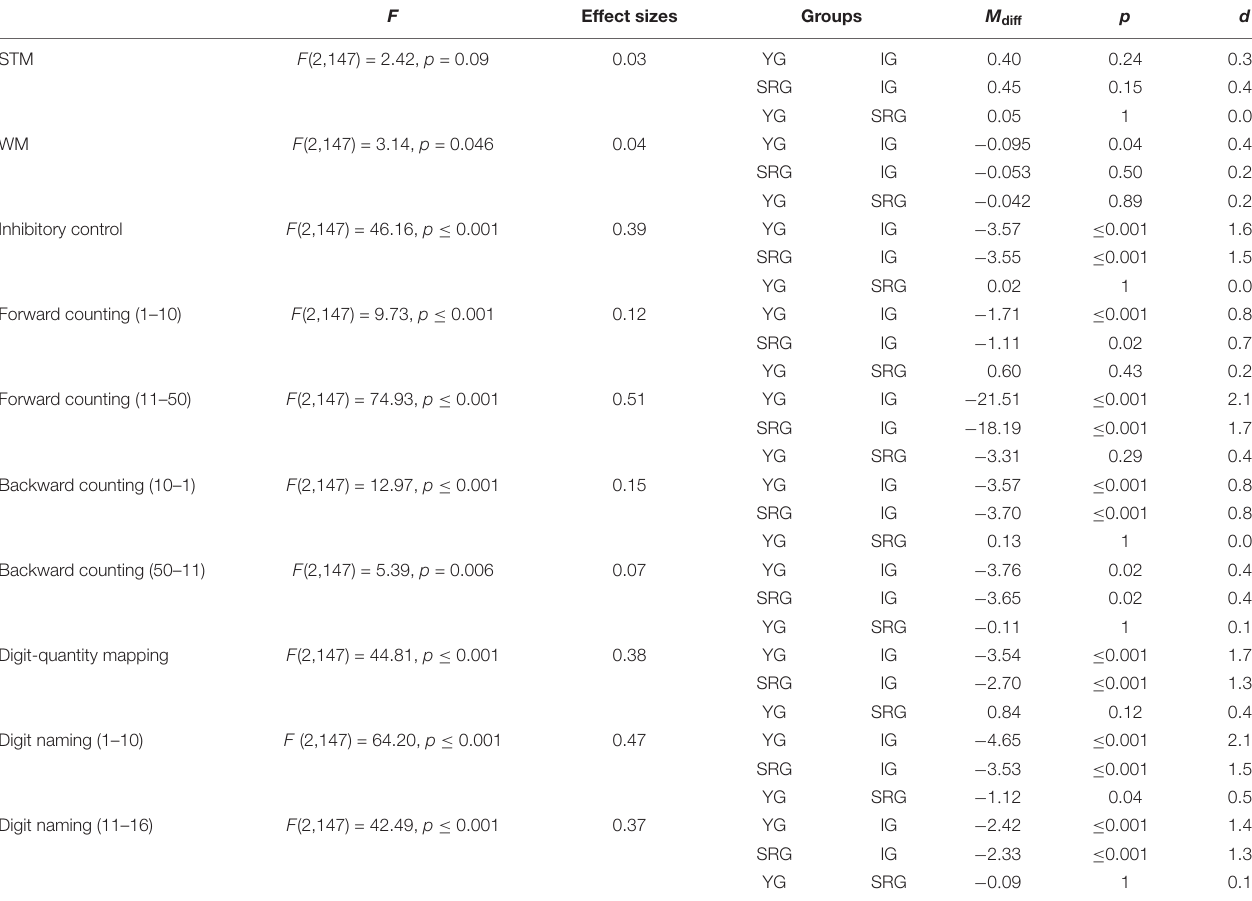
TABLE 4 | Univariate test results and Bonferroni’s adjusted post hoc pair-wise comparisons from MANOVA between the three groups of children (SRG, YG, and IG). F Effect sizes